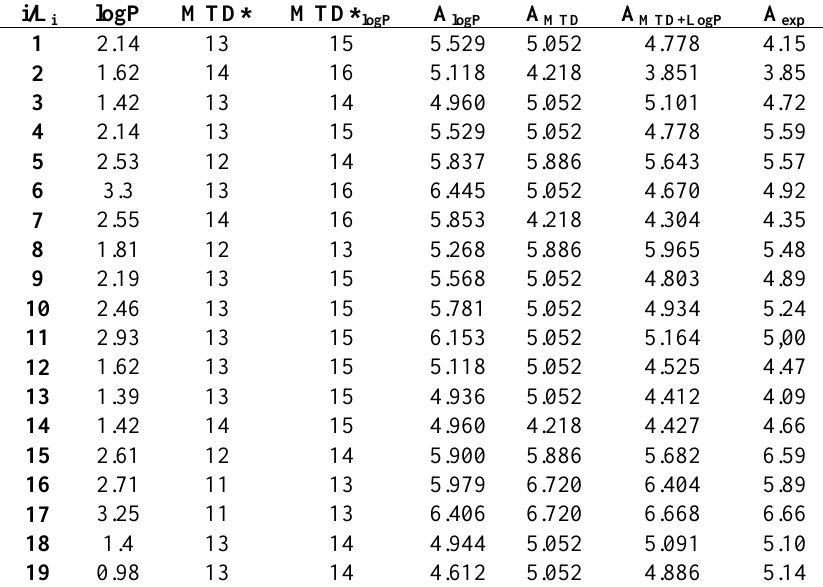
) are taken from ref. activities (A exp